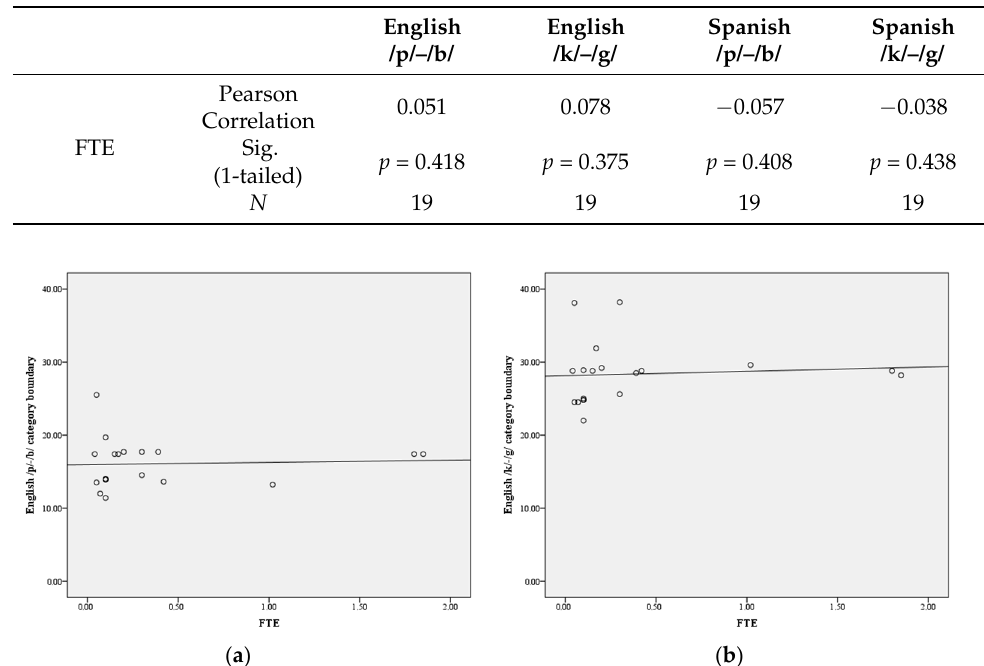
Figure 1. Scatterplots with fit lines for FTE ( x axis) and category boundary ( y axis) in English by the English learners of Spanish. ( a ) Category boundary for the /p/–/b/ contrast in English. ( b ) Category boundary for the /k/–/g/ contrast in English.